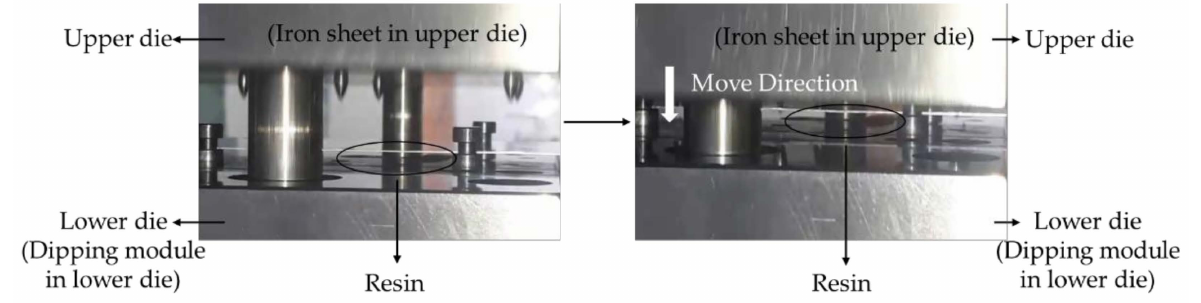
Figure 1. Motor core manufacturing process